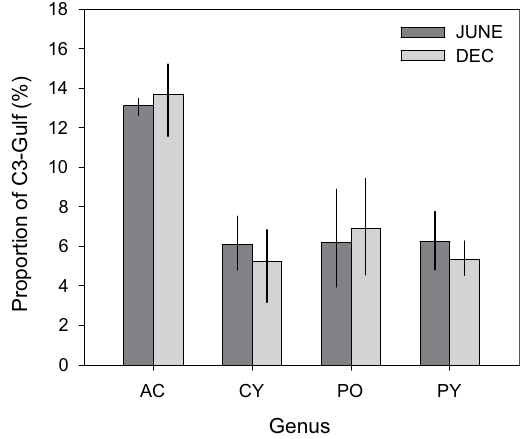
Figure 5. Proportion of C3 reads containing the 8 bp C3-Gulf insertion characteristic of Symbiodinium thermophilum collected in June and December 2014. Error bars show the 95% confidence intervals. AC = Acropora , CY = Cyphastrea , PO = Porites , PL = Platygyra